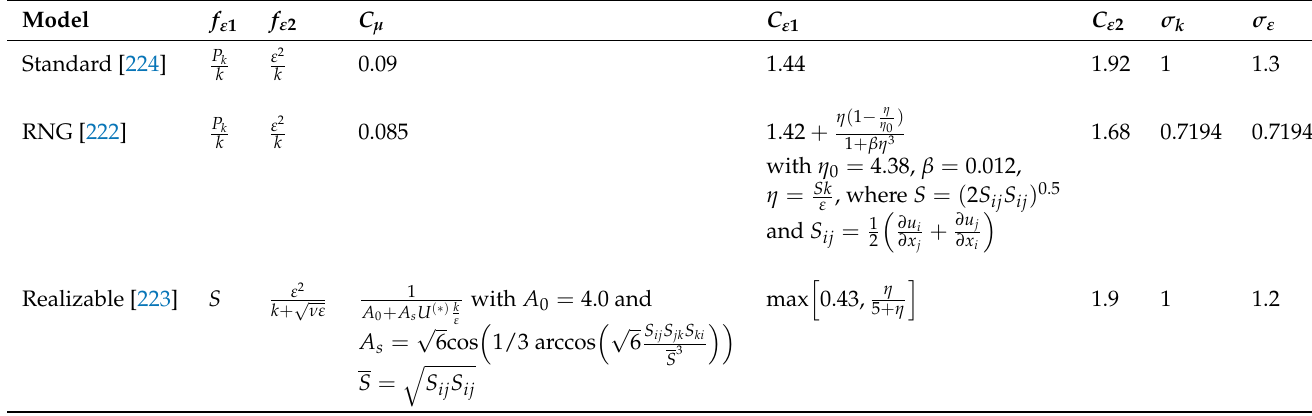
Table 4. Overview of different k - ε turbulence models. The listed expressions refer to